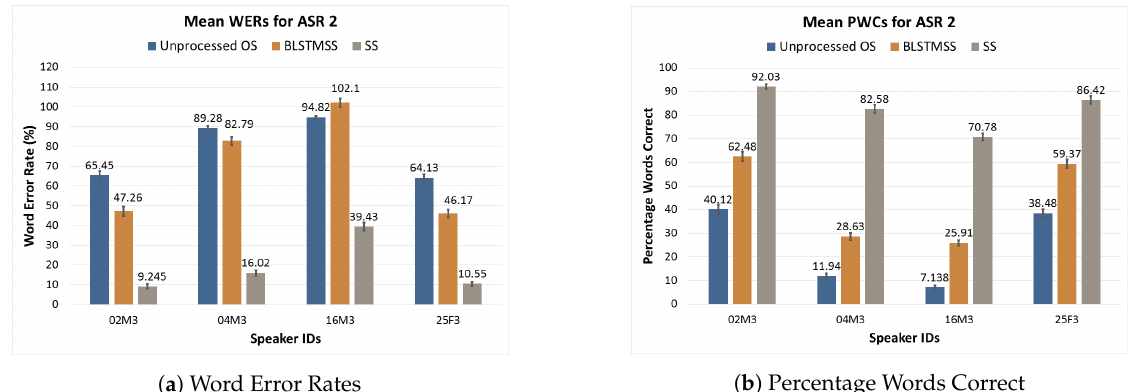
Figure 3. ASR 2 WER and PWC scores for unprocessed OS (source), the BLSTMSS converted outputs and target SS (target). Error bars show standard errors.